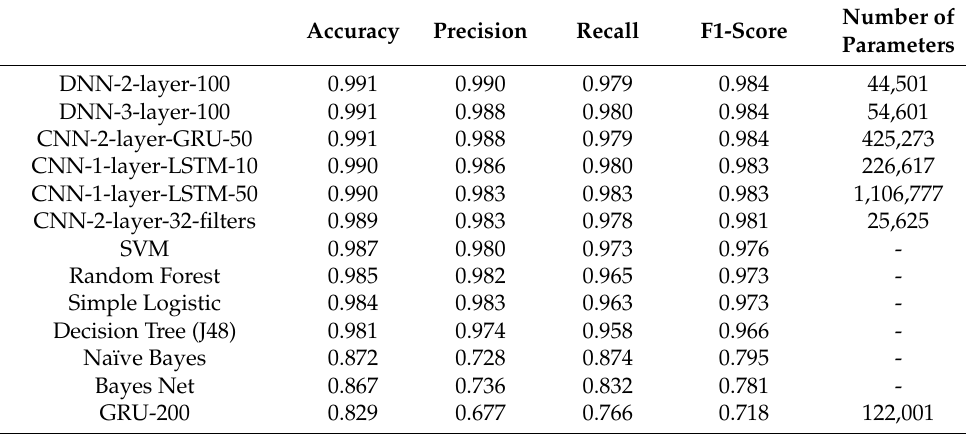
Table 8. A summary of the best results of each technique compared to popular non-deep learn- ing classifiers.